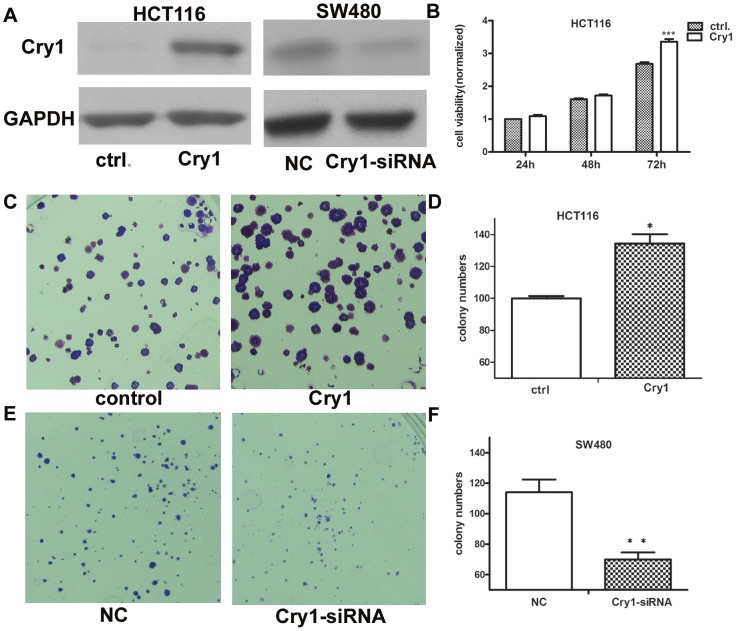
Effects of Cry1 on cell growth.(A) Cry1 protein levels were upregulated in HCT116 cells and downregulated in SW480 cells. (B) MTT assays on HCT116 cells 24, 48, and 72 h after transfection with Cry1 or GFP control (***, p<0.001). (C–D) Colony formation assay of HCT116 cells transfected with Cry1 or GFP control (*, p = 0.033). (E–F) Inhibition of SW480 cell colony formation capacity by Cry1 siRNA relative to control (**, p = 0.007). Experiments were repeated at least three times, and representative data are presented; bars, SD.*, P<0.05; **, P<0.01, ***, p<0.001.